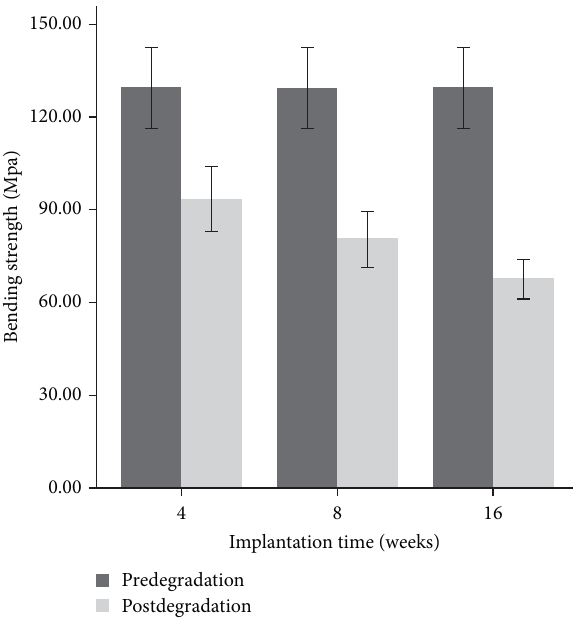
F IGURE 10: Bending strength of magnesium alloy plate before and at 4, 8, and 16 weeks after